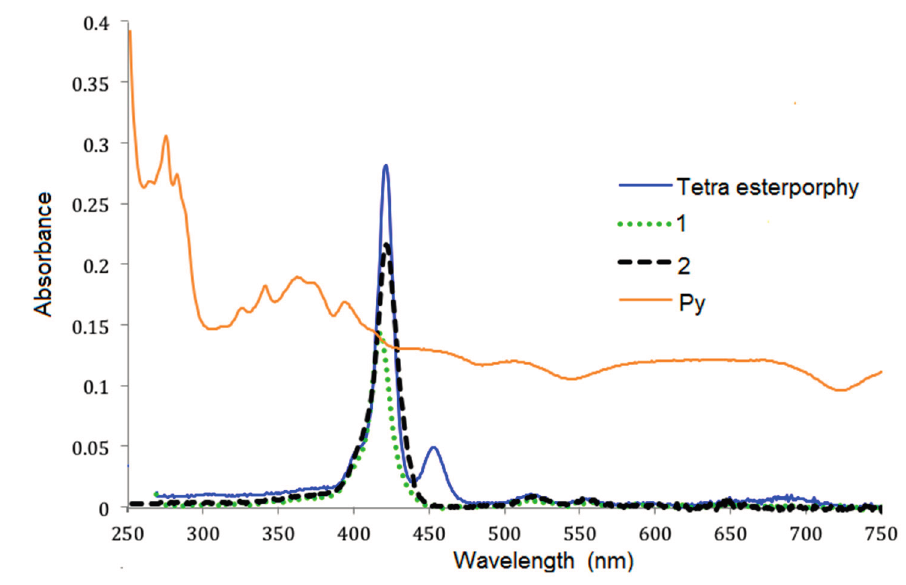
Figure 1. Absorption spectra of 1-pyrenecarboxaldehyde, tetra esterporphyrin and dendrimers